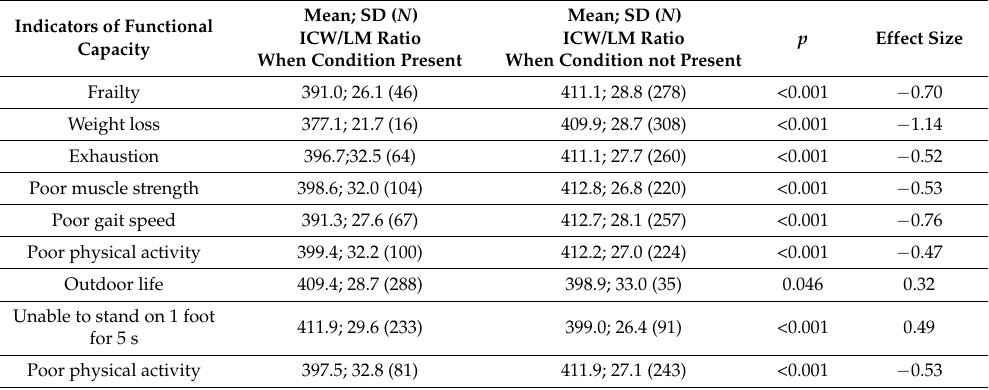
Table 3. Relationship between ICW/LM ratio (in mL/kg) and indicators of functional capacity and frailty (categorical variables).